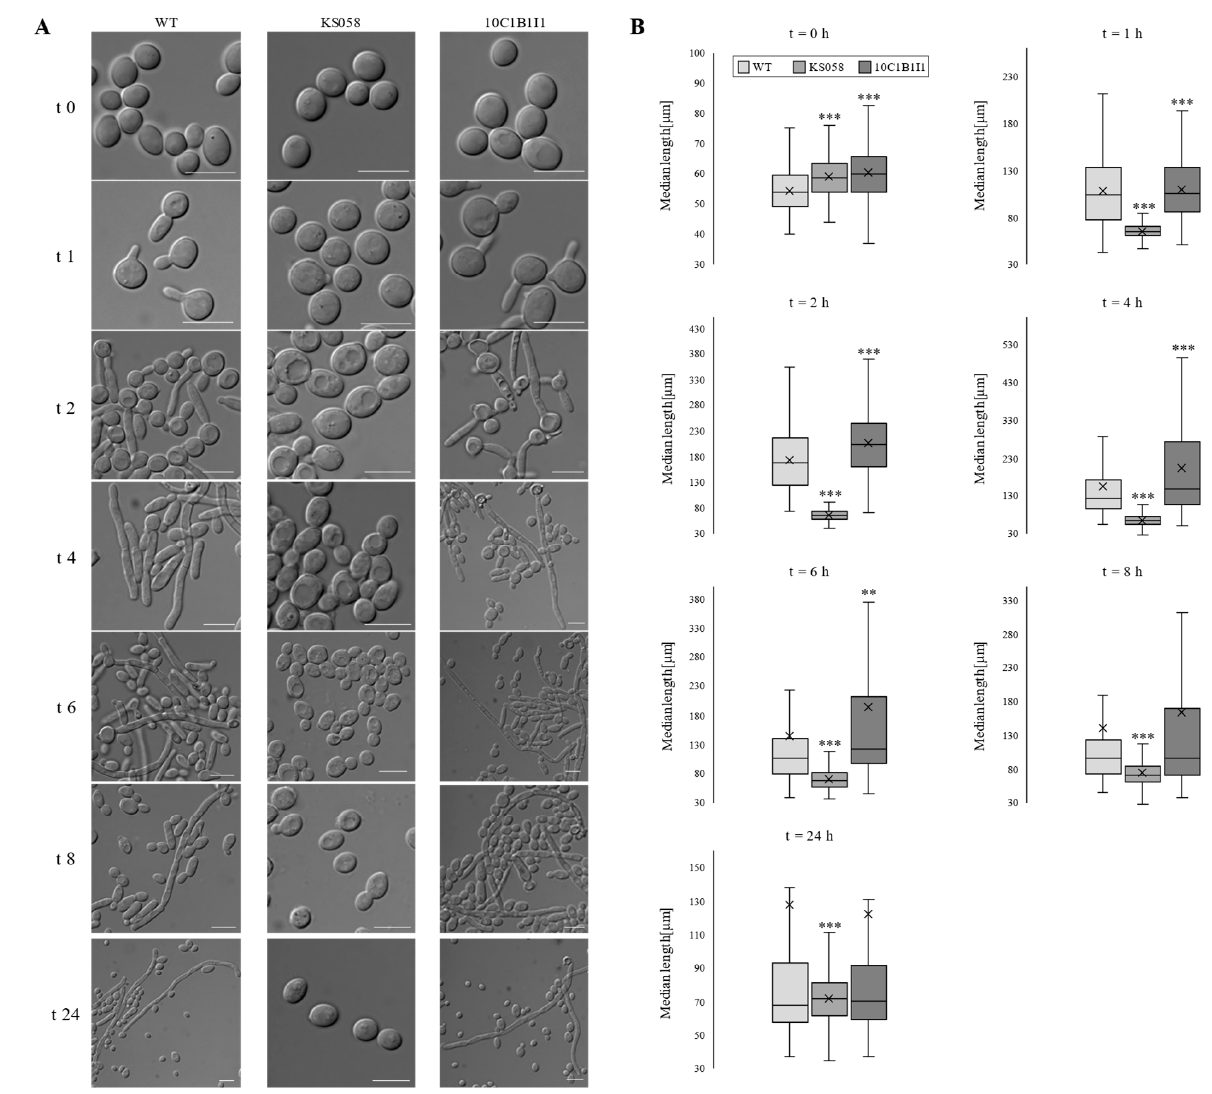
Figure 2. Filamentation of C. albicans WT (SC5314), KS058 ( erg11 Δ / Δ ) and 10C1B1I1 ( ERG11 K143R / K143R ) strains in the presence of 20% fetal bovine serum (FBS) in YPD medium. ( A ) Microscopic study of C. albicans strains performed in different time points of culture in the presence of 20% FBS (time points: 0, 1, 2, 4, 6, 8 and 24 h of culture). The figure presents representative micrographs for each condition (scale bar 100 µm). ( B ) Median length of C. albicans WT, KS058 and 10C1B1I1 cells measured in different time points of culture with 20% FBS ( n = 300). The “x” on the median bars represents mean values. Mean data (±SD) collected for C. albicans KS058 and 10C1B1I1 were compared to those obtained for the WT strain (**, p < 0.01; ***, p < 0.001).